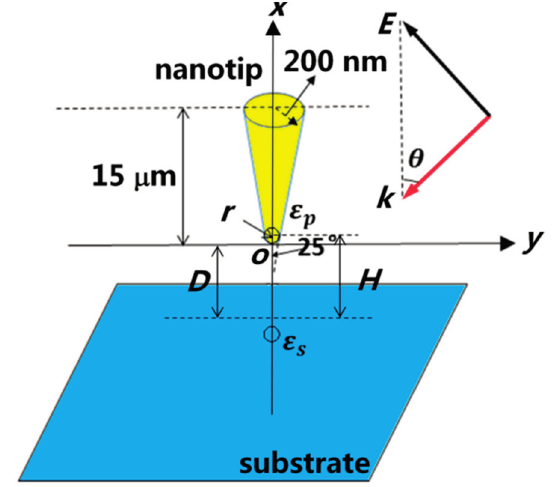
Figure 1. Model of a terahertz (THz) near-field microscopy composed of a nanotip and a substrate under the THz